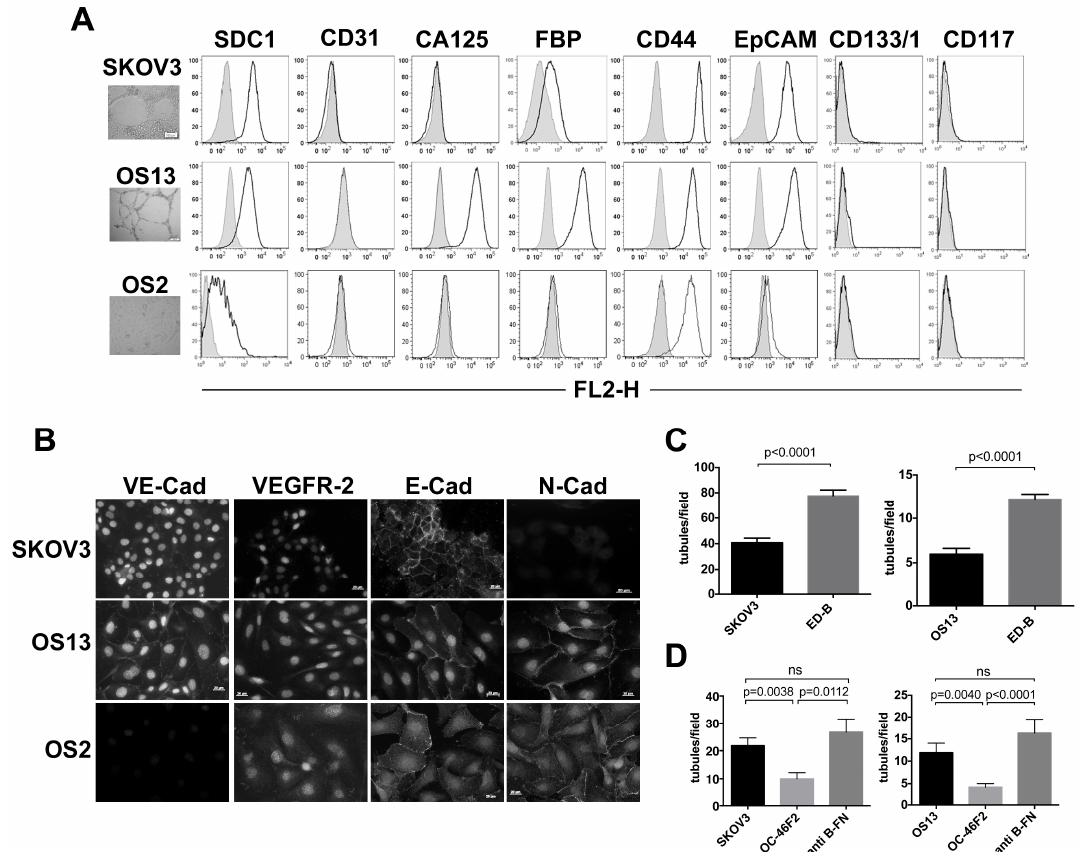
Figure 2. SDC1 and B-FN involvement in the VM process in ovarian cancer. ( A ) Flow cytofluorimetric analysis of SDC1, CD31, CA125, FBP (folate-binding protein), CD44, EpCAM (epithelial cell adhesion molecule), CD133 / 1, and CD117 expression in VM positive human ovarian carcinoma cell line SKOV3 and serous ovarian carcinoma cell OS13 in comparison to VM-negative clear cell carcinoma cell OS2. Gray profiles represent negative controls. In vitro Matrigel tube formation using SKOV3 ovarian cell line, OS13, and OS2 ovarian cells is reported. Scale bars, 100 µ m. ( B ) Immunofluorescence analysis of SKOV3, OS13, and OS2 ovarian carcinoma cells stained with VE-cadherin (VE-cad), VEGFR-2, E-cadherin (E-cad), and N-cadherin (N-cad) counterstained with DAPI (4’,6’-diamidin-2-fenilindolo). Scale bars, 20 µ m. ( C , D ) In vitro Matrigel tube formation using SKOV3 or OS13 cells in the presence of ED-B or untreated ( C ) and in the presence of scFv OC-46F2 or scFv anti-B-FN in comparison to untreated cells ( D ). The di ff erences in tube formation for di ff erent treatments were quantified by column bar graphs. The means ± SE are indicated. Statistically di ff erences p values between the groups connected by lines are also reported. Note: ns = no significant di ff erences between the indicated groups.